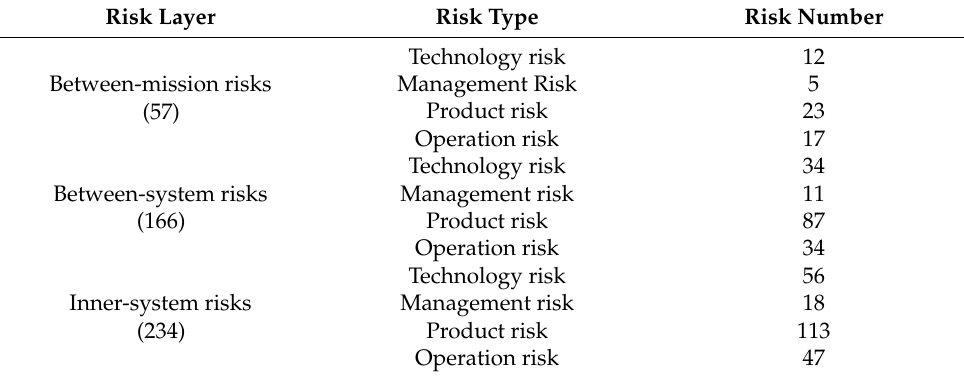
Table 1. Numbers of Multi-layer and Multi-type risks identified.